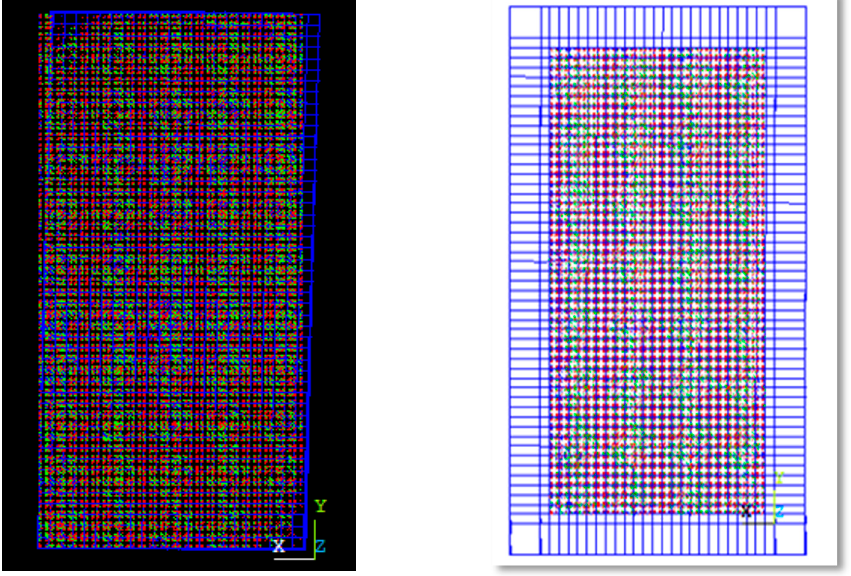
Figure 8. Concrete crack formation for numerical specimen.